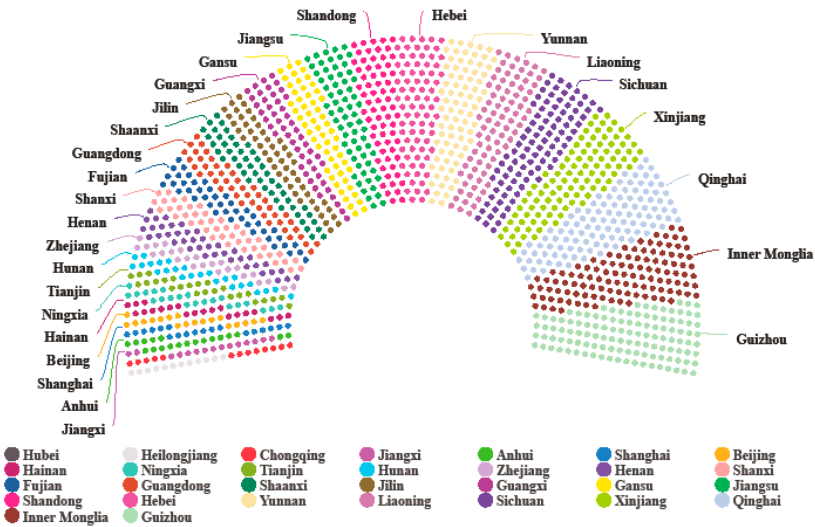
Figure 7. Distribution of the “COVID-19 safety index” scores in 333 cities in mainland China. In particular, Figure 6 represents each province’s distribution of the COVID-19 safety index scores. The larger the area of the sector occupied, the higher the COVID-19 safety index score. Figure 7 reflects the level of safety in mainland Chinese cities in the case of a COVID-19 outbreak in 2020. In this case, darker colors indicate lower risk, and vice versa.